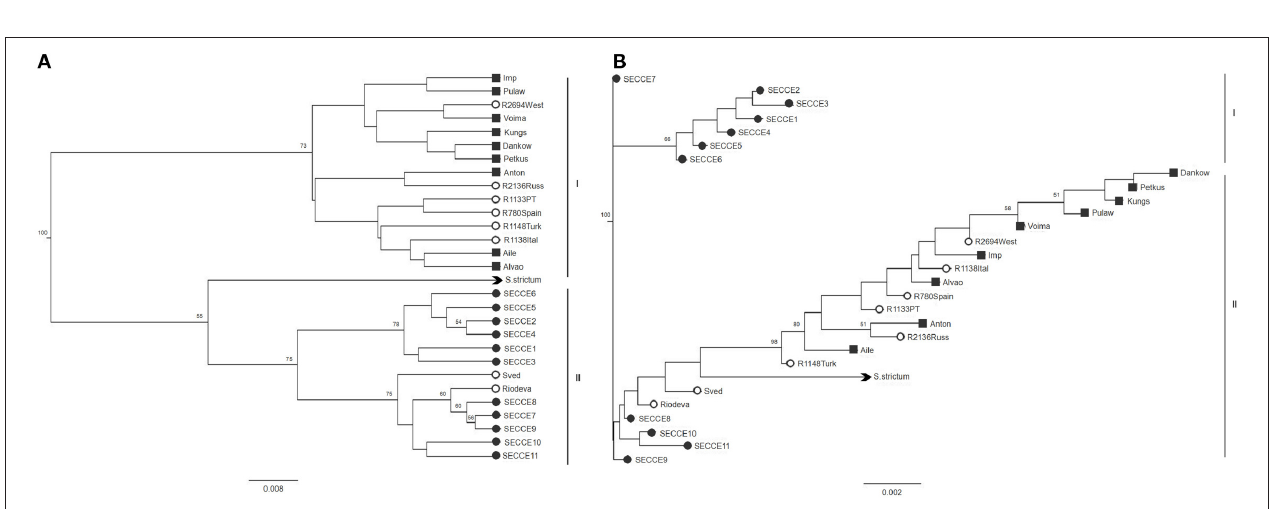
FIGURE 2 | Scatter plots of genetic distance vs. geographical distance for pairwise population comparisons. Each point represents one population pairwise using Slatink’s linearized (A) F STENA /(1 − F STENA ; R 2 = 0.1612, R xy = 0.402, P = 0.001; 999 permutations) and (B) F ST /(1 − F ST ; R 2 = 0.14067, R xy = 0.375, P = 0.002; 999 permutations) plotted against geographic distance (Km).